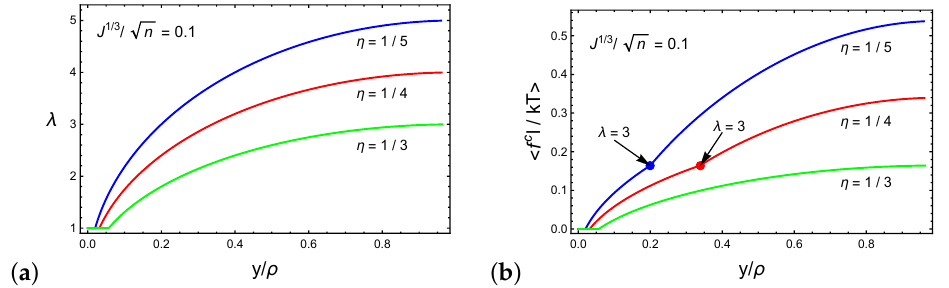
Figure 5. ( a ) The stretch of a chain λ and ( b ) the average force on a chain (cid:104) f c l / kT (cid:105) as a function of the normalized sink y / ρ for spherical or ellipsoidal particles characterized by the ratio J 1/3 / three representative ratios η =